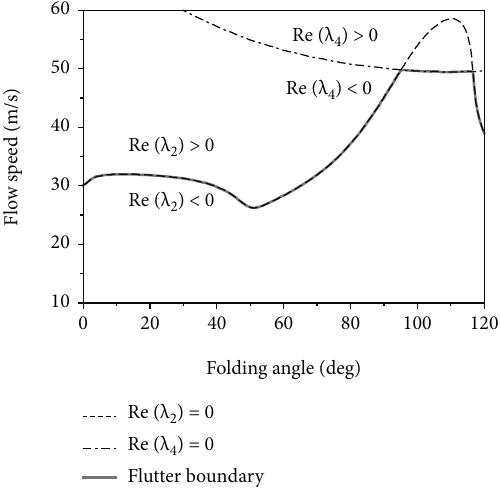
Figure 12: Contour lines of critical eigenvalues and the fl utter boundary.